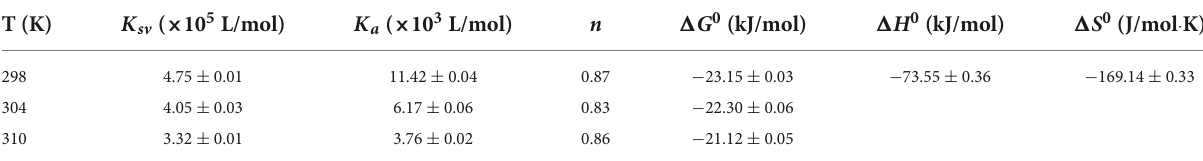
TABLE 2 Quenching constants ( K sv ), binding constant ( K a ), number of binding sites ( n ), and thermodynamic parameters of the interaction between α -glucosidase and EA at different